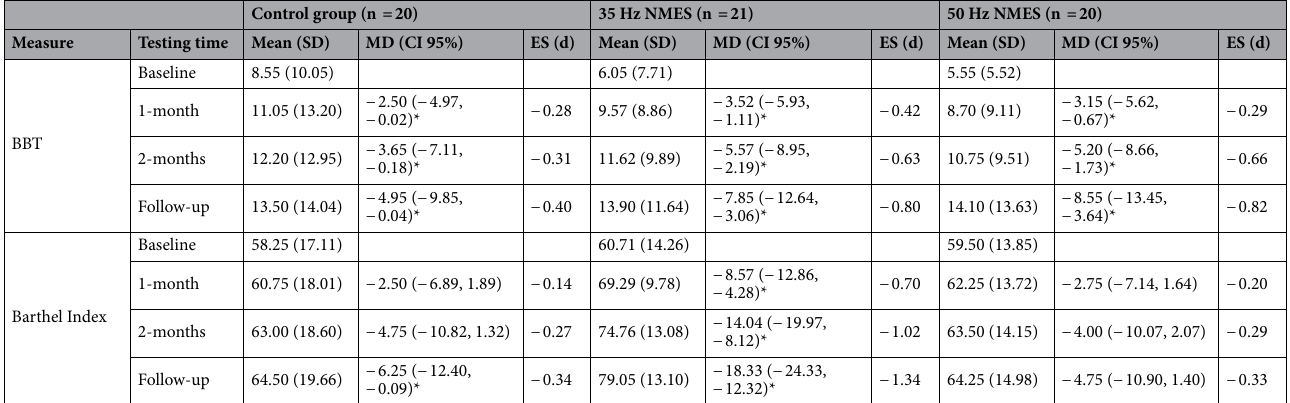
Table 5. Means, standard deviations, mean differences, confidence intervals and effect sizes of functional outcome measures in all the time points. BBT Box and Block Test, SD Standard deviation, MD Mean difference